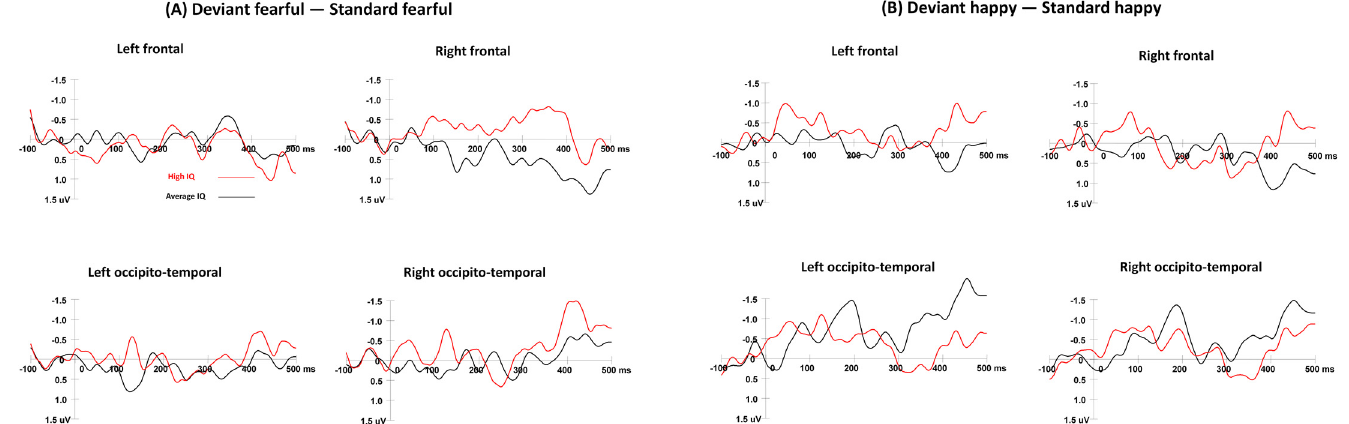
Fig 3. vMMN componentsin the fearful (Fig 3A) and happy oddball (Fig 3B) conditions. The vMMNs in the deviant fearful minus standard fearful condition, and the left frontal waveform was the average neural activation at electrodes of F1, F3, and F5. The right frontal waveform was obtained from F2, F4, and F6. The left occipito-temporal waveform was from TP7, P7, PO7, CB1, and O1. The right occipito-temporal waveform was from TP8, P8, PO8, CB2, and O2.